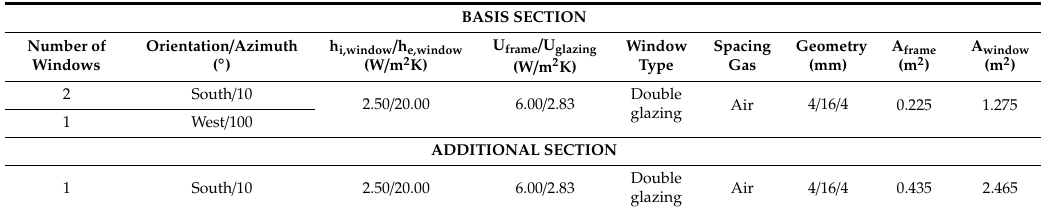
Table 3. The characteristics of the windows of the house.